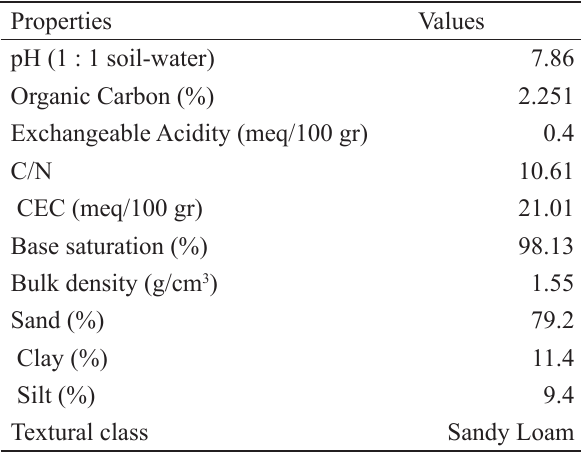
Table 1: Pre-Soil Physical and Chemical Properties